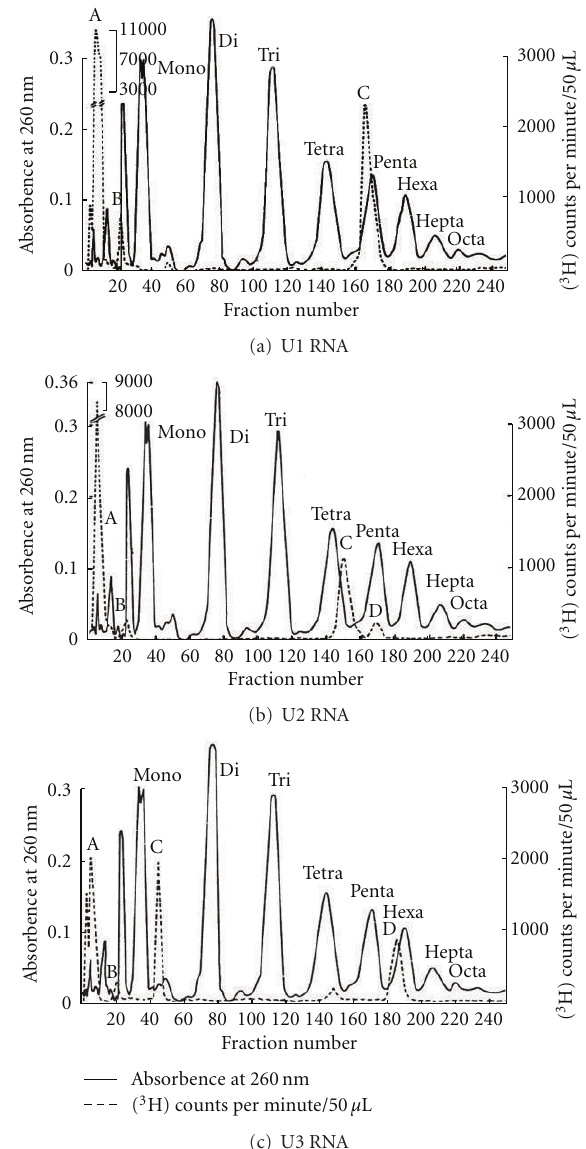
Figure 15: DEAE-Sephadex chromatography of 5 (cid:2) oligonucleotide [37]. The U1 RNA, U2 RNA, and U3 RNA collected from prepar- ative gel electrophoresis (Figure 13) were digested with RNase A and subjected to DEAE-Sephadex A-25 column chromatography. The radioactive peaks at nucleoside region were coming from 3 (cid:2) ends and the radioactivities at the regions of penta-, tetra-, and hexanucleotides were from 5 (cid:2) end labeling. These fragments were treated with T1 RNase and found to be shortened by one nucleotide only in U3 5 (cid:2) oligonucleotide indicating that G was next to the terminal pyrimidine